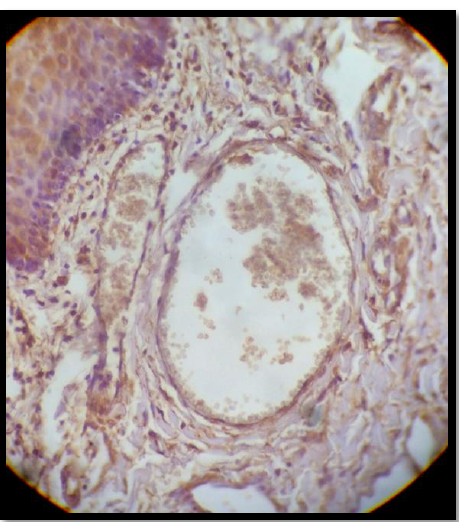
Figure (2): Photomicrograph in lymphangioma display ESM-1 immunostaining positive blood vessels (X400)